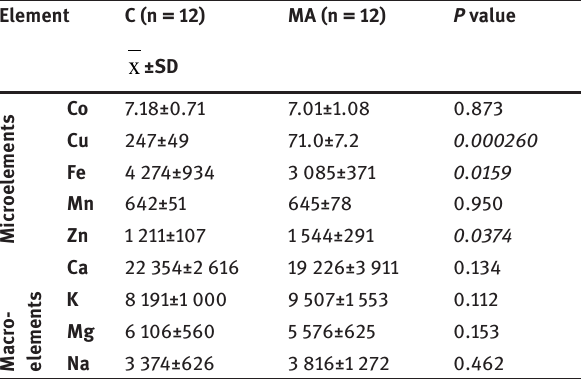
Table 10 The effect of enriched macroalgae on the average content of elements in feces of examined pigs (mg kg -1